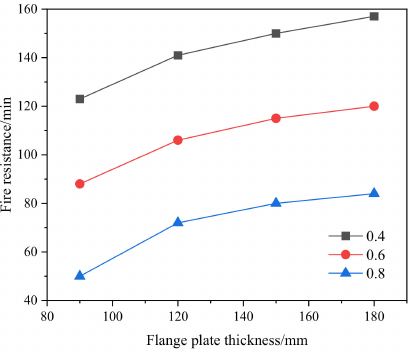
Figure 12. Curves of the effect of different flange plate thicknesses on the fire resistance of